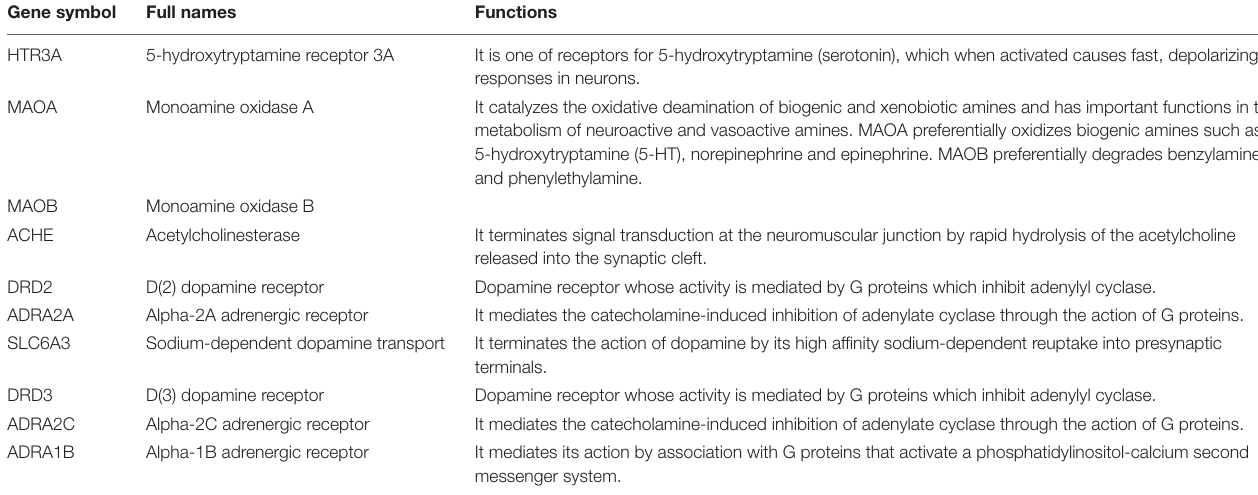
TABLE 3 | Detail information of ten hub genes of candidate Chinese herbal medicine (CCHM) on methamphetamine (METH)